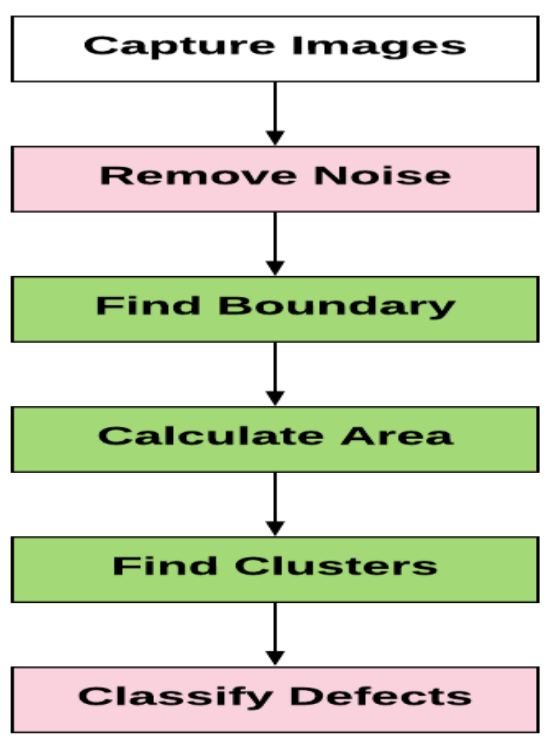
Figure 4. Defect detection schema.